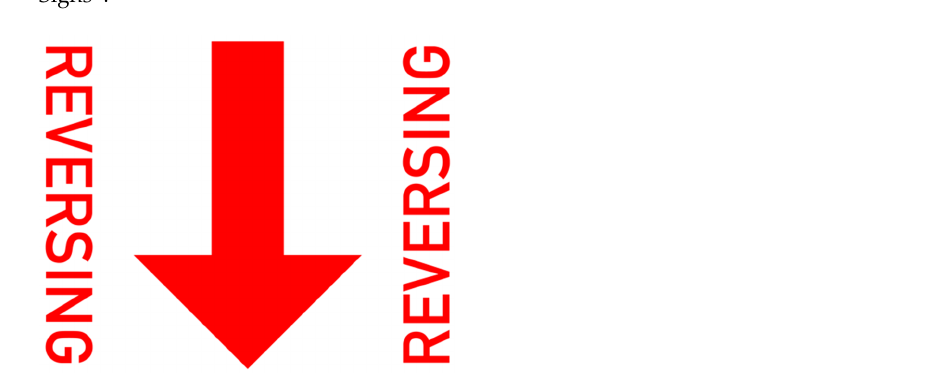
Figure 6. Projected graphic representing “Vehicle Intent”, hereafter referred to as “Reversing Ar- row”.